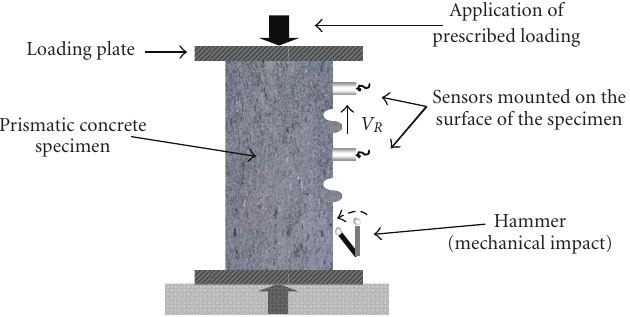
Figure 2: The schematics of the basic measurement